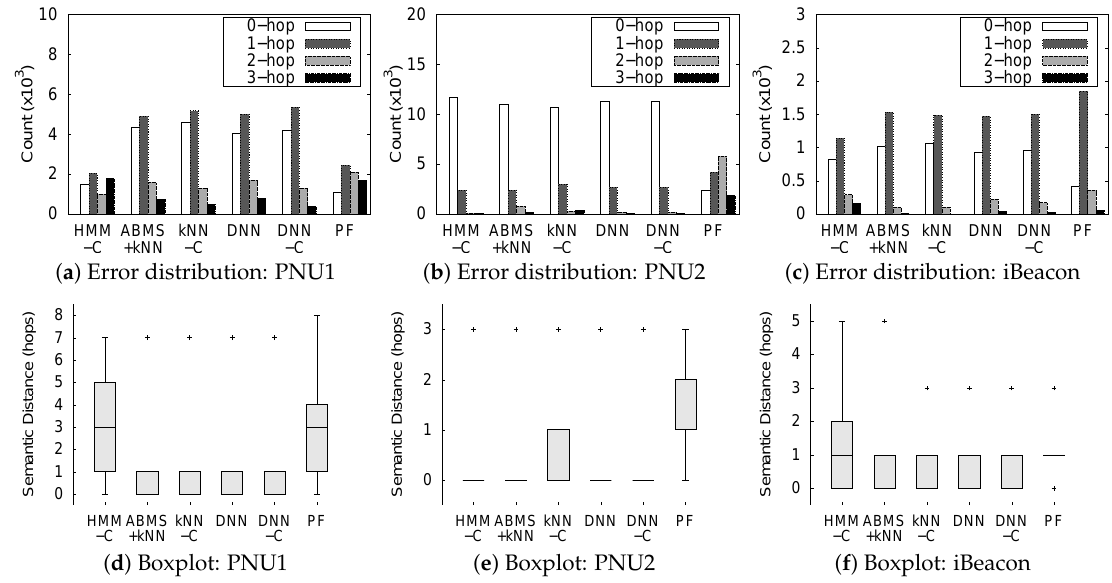
Figure 14. Error analysis of the indoor positioning predictions and the ground truth.